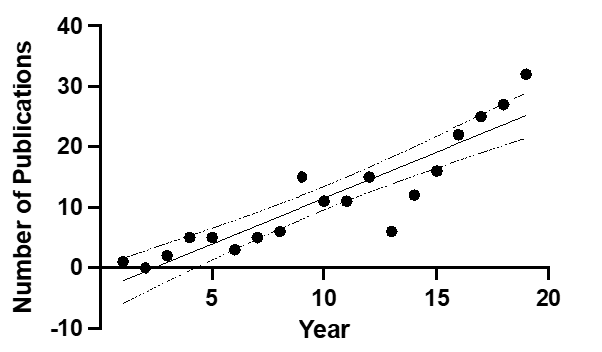
Figure 1 Linear regression of documents by